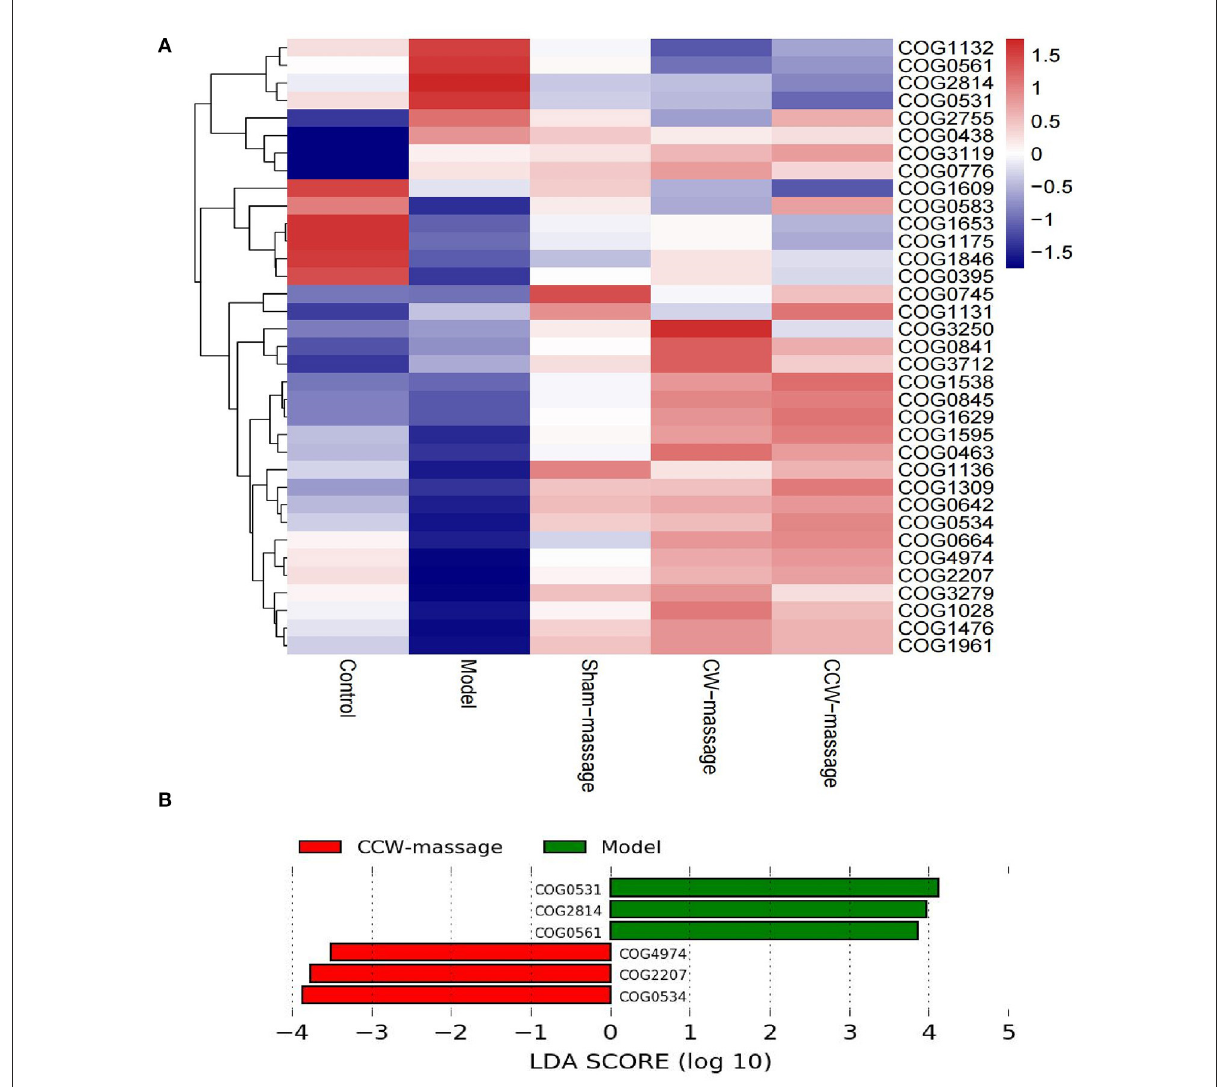
FIGURE7 COG Annotation and Analysis. (A) Heatmap of the relative abundances of COG categories between five groups [top 35 functions]. (B) LDA integrated with LEfSe comparison of relative abundances of COG categories between five groups (LDA > 2.0, P <